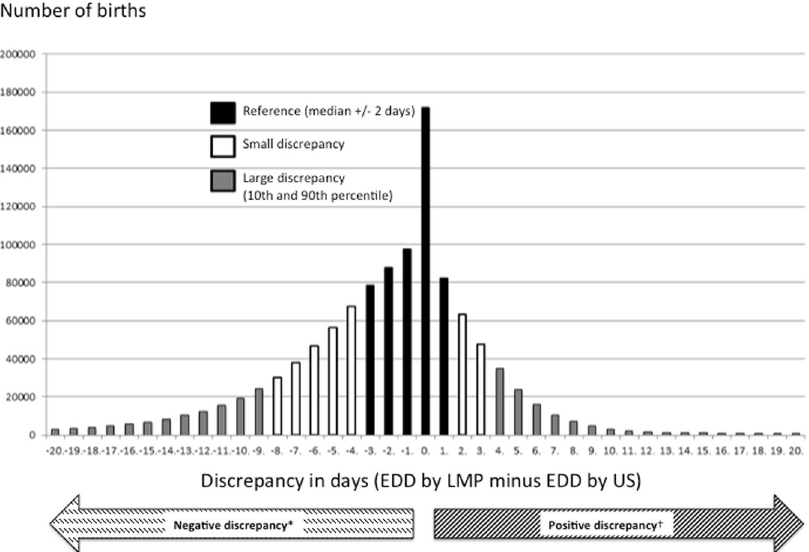
Figure 1. Number of births (n = 1 100 049) and discrepancy in days defined as the estimated date of delivery (EDD) by last menstrual period LMP minus EDD by ultrasound